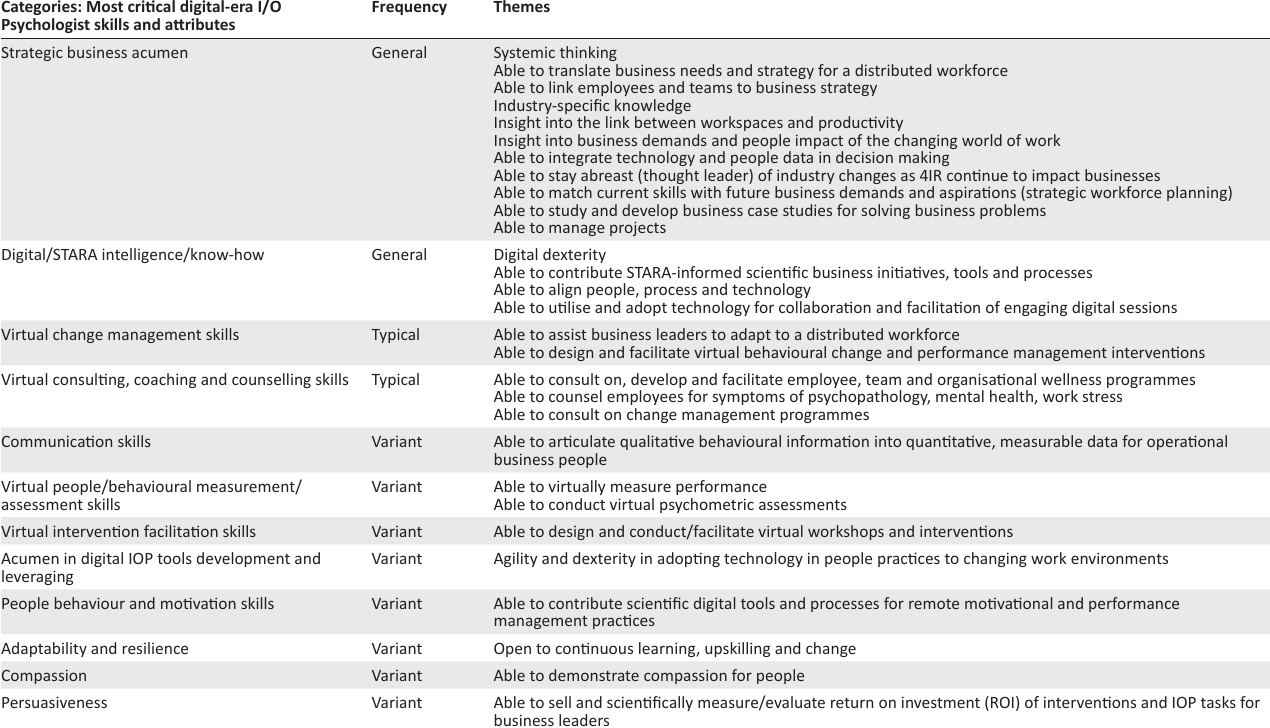
TABLE 2: Most critical digital-era skills and attributes: Categories, frequency and themes. Categories: Most critical digital-era I/O Psychologist skills and